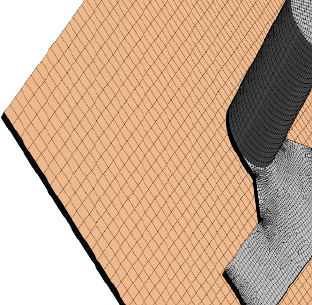
Figure 4. Close-up view of the structured multigrid. Below the membrane is the outflow zone, meshed finely in the direction of the flow.